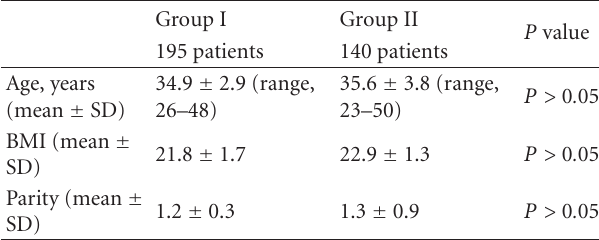
Table 1: Baseline characteristics of the study